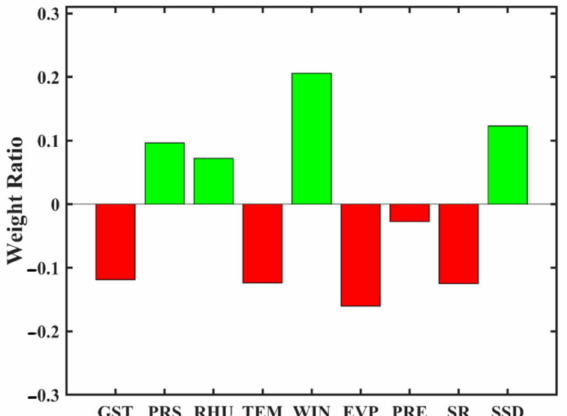
Figure 4. Weight ratio of climate parameters from the PLSR model for training and testing sets using climate data. GST, ground surface temperature ( ◦ C); PRS, pressure of the station (hPa); RHU, relative humidity (%); TEM, temperature ( ◦ C); WIN, wind speed (m/s); EVP, evaporation (mm); PRE, precipitation (mm); SR, solar radiation (MJ/m 2 ); SSD, sunshine duration (hour); YIELD, rice yield